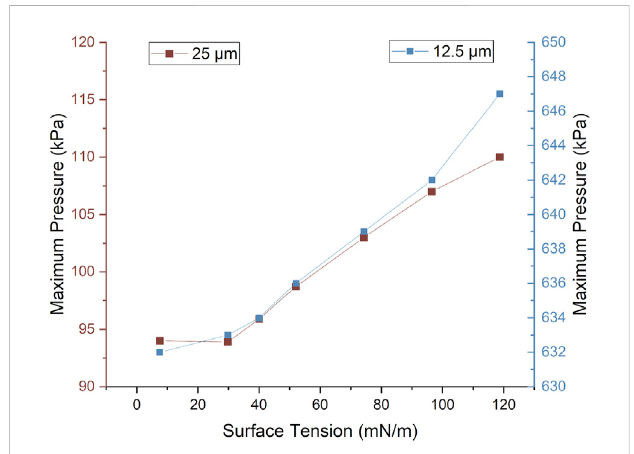
FIGURE 4 Maximum pressure recorded versus σ 0 for both the 12.5 and 25 µm neck widths.